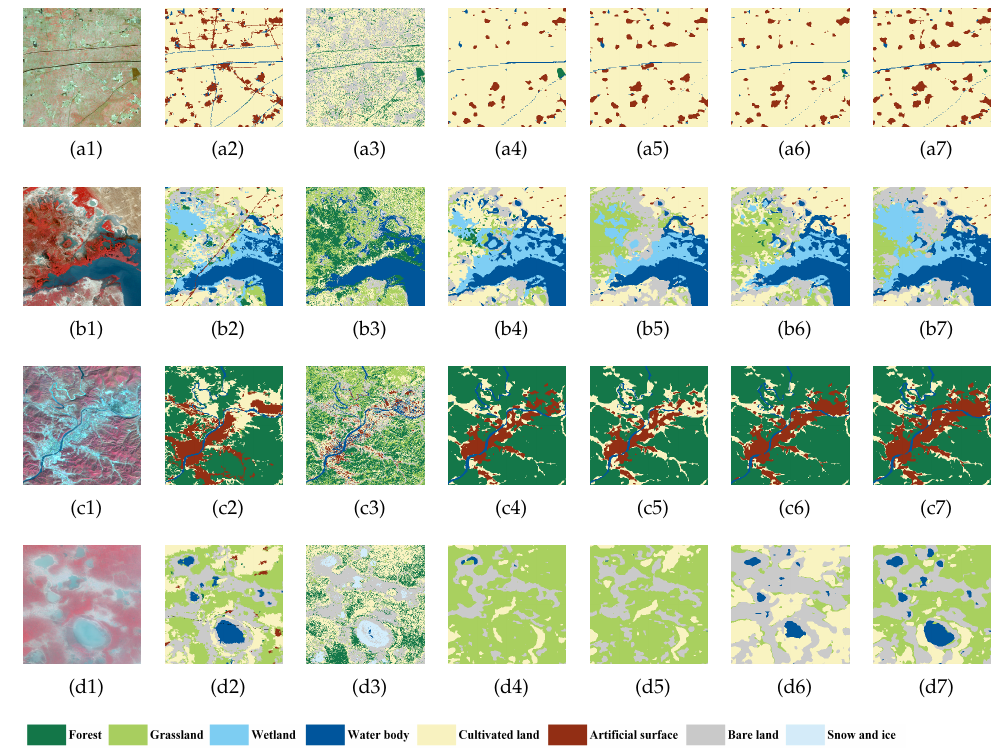
Figure 6. Detailed classification results for Liaoning, where ( a1 – d1 ) are the original Landsat images, ( a2 – d2 ) are the reference, ( a3 – d3 ) are classification results for RF classifier, ( a4 – d4 ) are classification results of PSPNet-RL, ( a5 – d5 ) are classification results of PSPNet, ( a6 – d6 ) are classification results of PSPNet-TF and ( a7 – d7 ) are classification results of MTNet. The results shown in ( a1 – b7 ) are for the year 2005; the results shown in ( c1 – d7 ) are for